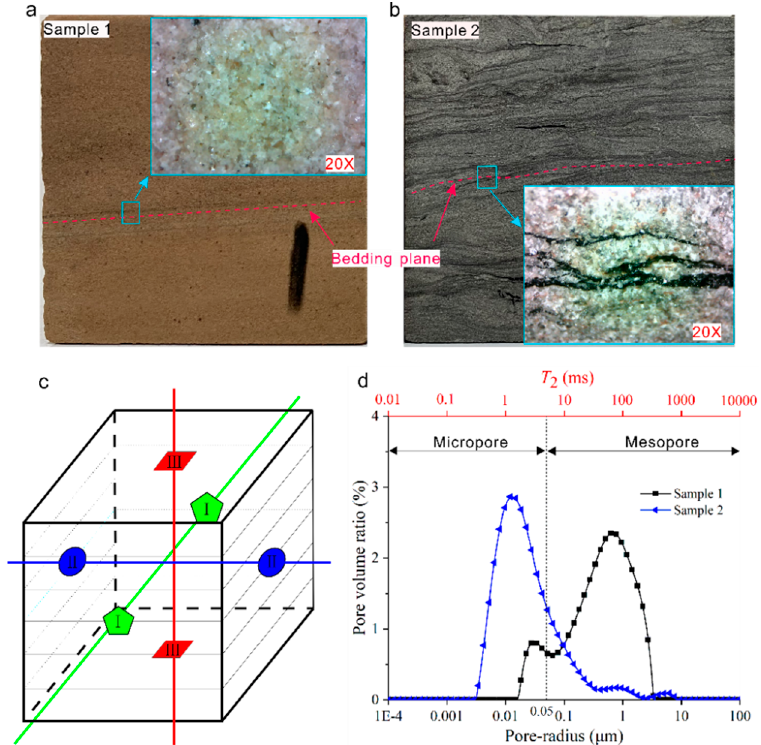
Figure 1. ( a , b ) Photographs of test samples, ( c ) Schematic diagram of ultrasonic testing direction and ( d ) pore size distributions based on T 2 spectra.